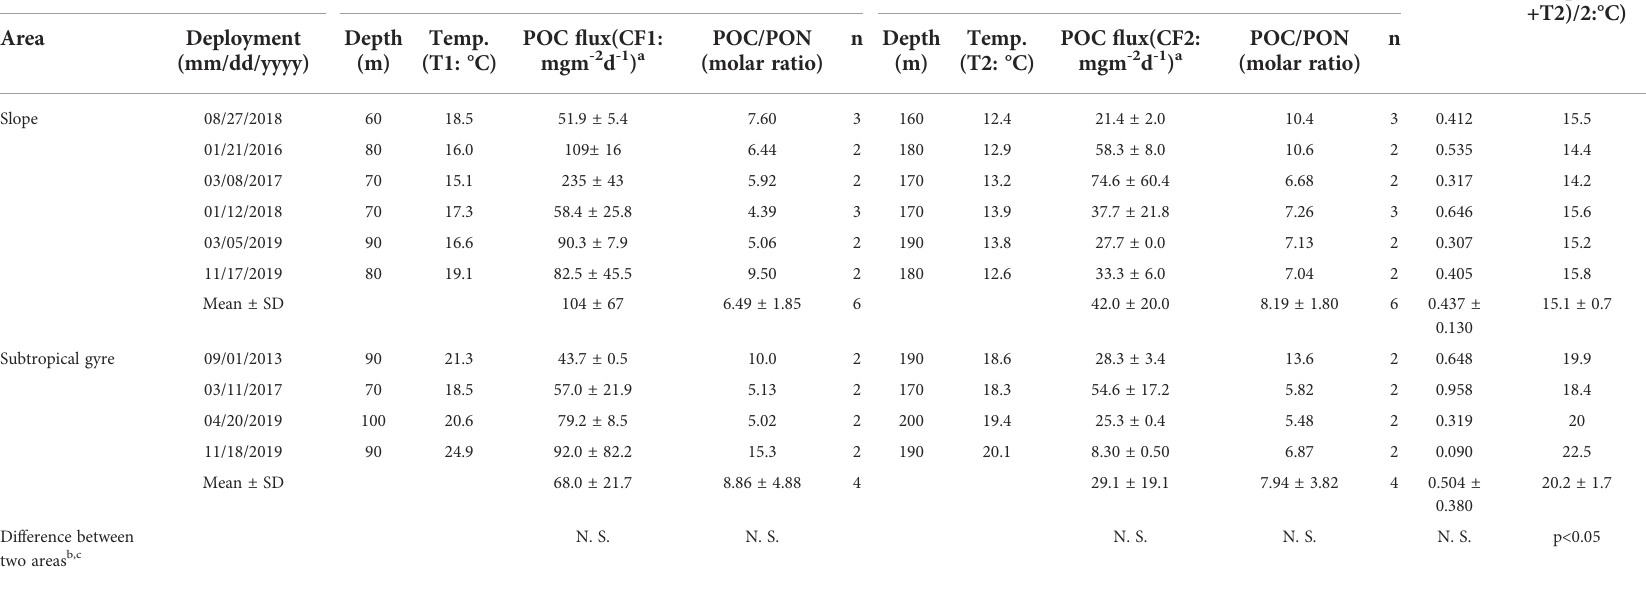
Trap deployed at Z eu +100 m T 100 (CF2/